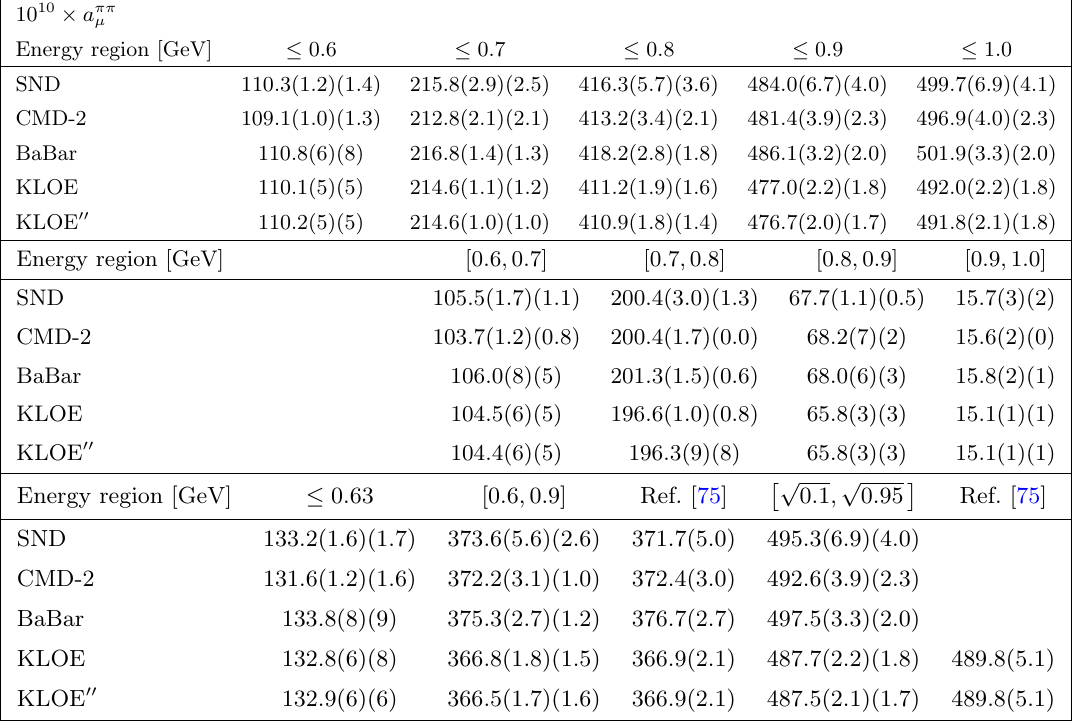
p (cid:12)t uncertainty, in(cid:13)ated by (cid:31) 2 = dof, the second error the combination of all systematic